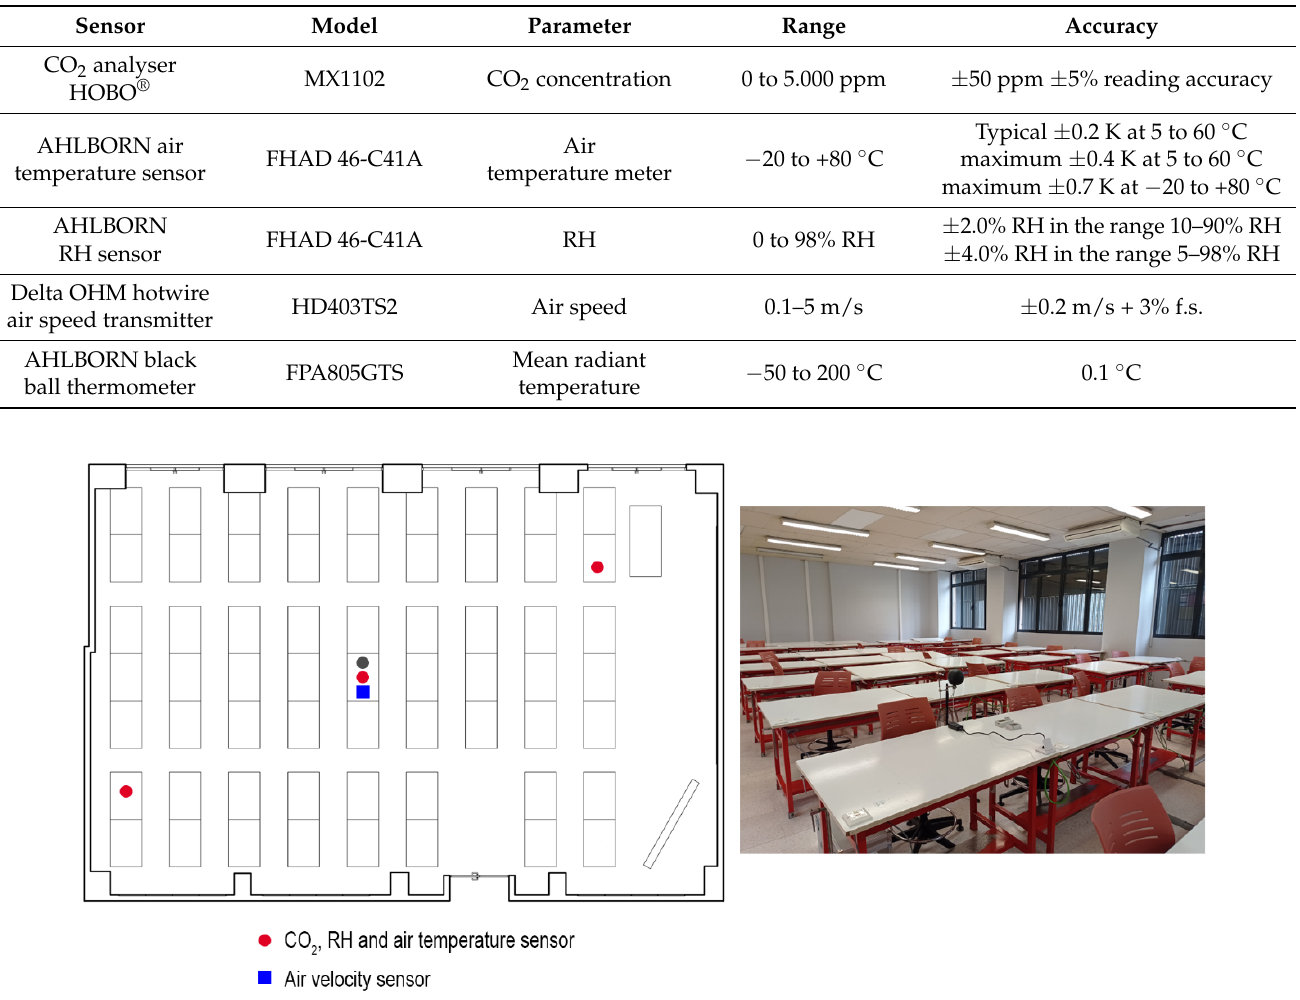
Table 2. Characteristics of the sensors used in the field measurement campaign.